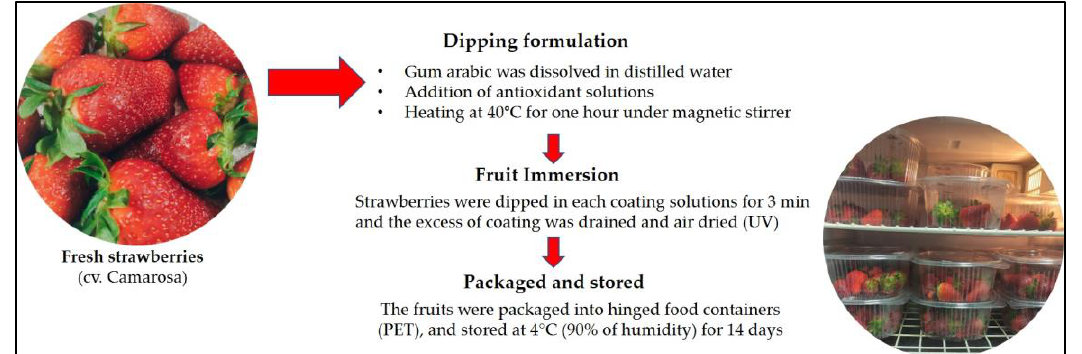
Figure 2. Schematic overview of the sample preparation process.